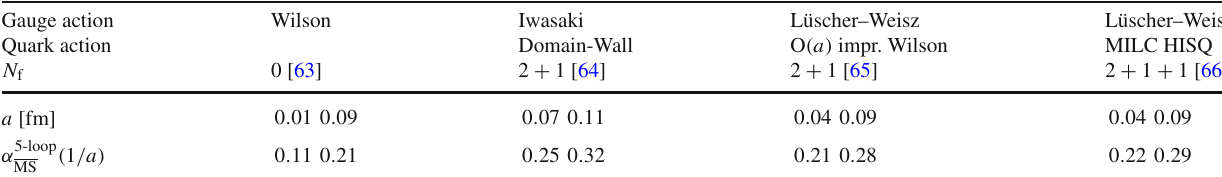
Table 2 Non-exhaustive overview of typical lattice spacings in today’s lattice QCD simulations combined with the MS coupling at scale μ = 1 / a obtained from 5-loop running [50]. The MILC HISQ ensem-